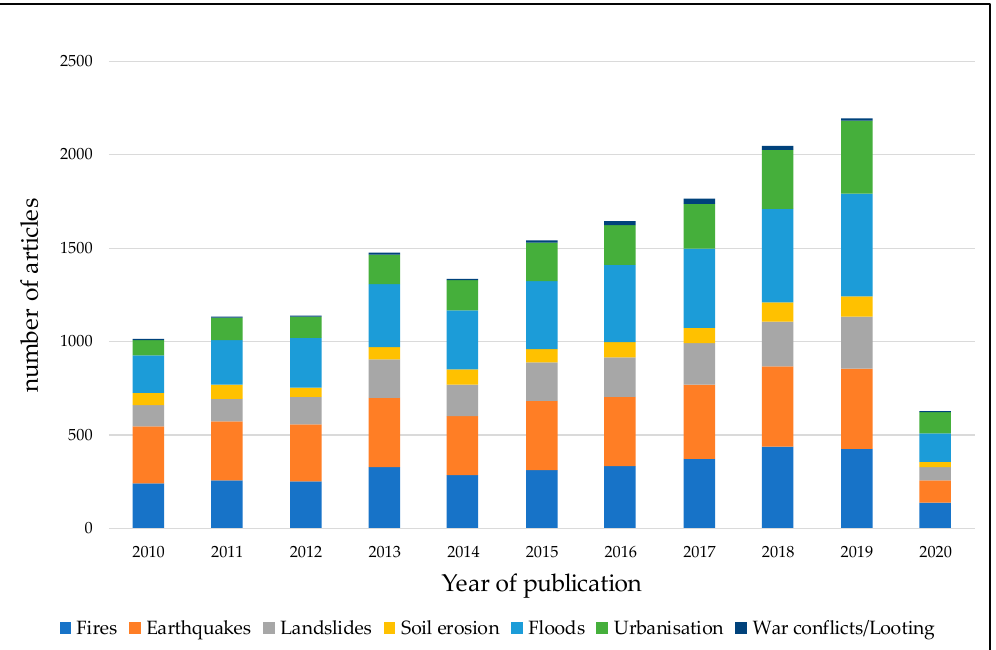
Figure 1. The total numbers of published articles related to various hazards with the support of satellite and space-based observations for the last decade (2010–2020) (results from Scopus engine database).